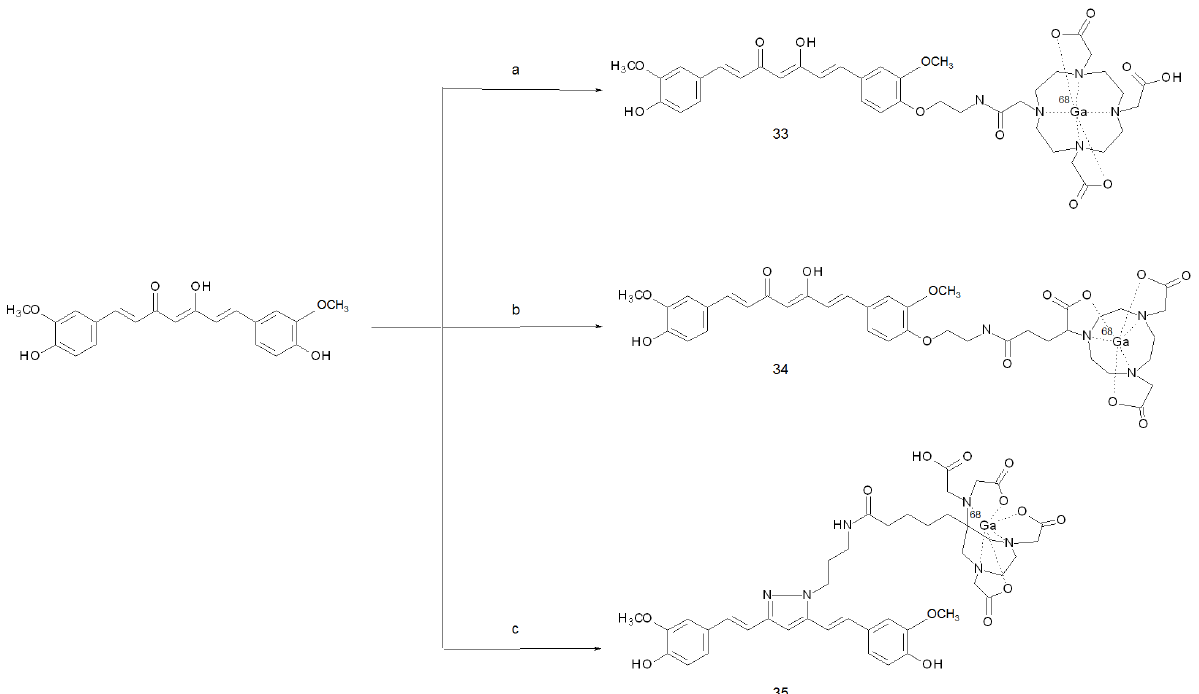
Figure 11. Reagents and conditions: ( a ) 1, 2-(Boc-amino)ethyl bromide, K 2 CO 3 , DMF, RT, 48 h, 2, TFA/DCM 2/8, RT, 30m, 3, DOTA-NHS ester, DIPEA, DMF, 1 h, 4, 68 Ga 3+ (0.05 M HCl), 1.5 M CH 3 COONa (pH 5), 95 °C, 5 min; ( b ) 1, 2-(Boc-amino)ethyl bromide, K 2 CO 3 , DMF, RT, 48 h, 2, TFA/DCM 25/75, RT, 30m, 3, NODAGA(tBu) 3 , HBTU, DIPEA, DMF, 1 h, 4, 80% TFA/DCM, RT, 3 h, 5, 68 Ga 3+ (0.05 M HCl), 1.5 M CH 3 COONa (pH 5), 95 °C, 5 min; ( c ) 1. tBuHPC, CH 3 COOH, reflux, 6 h, 2, TFA/DCM 25/75, RT, 30m, 3, AAZTA-HBTU ester, DIPEA, DMF, RT, 8 h, 4, TFA/TIS/H 2 O 90/5/5, RT, 2 h, 5, 68 Ga 3+ (0.05 M HCl), 1.5 M CH 3 COONa (pH 5), RT, 5 min.